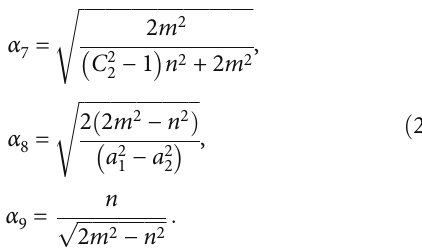
Figure 5: 3D plot of solution (28) of PDE (1).